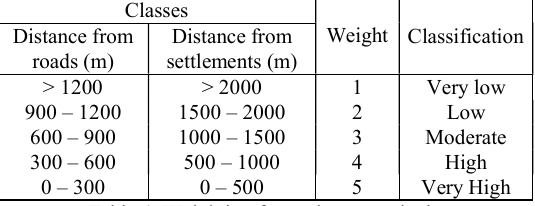
Table 4. Weighting for socioeconomic data